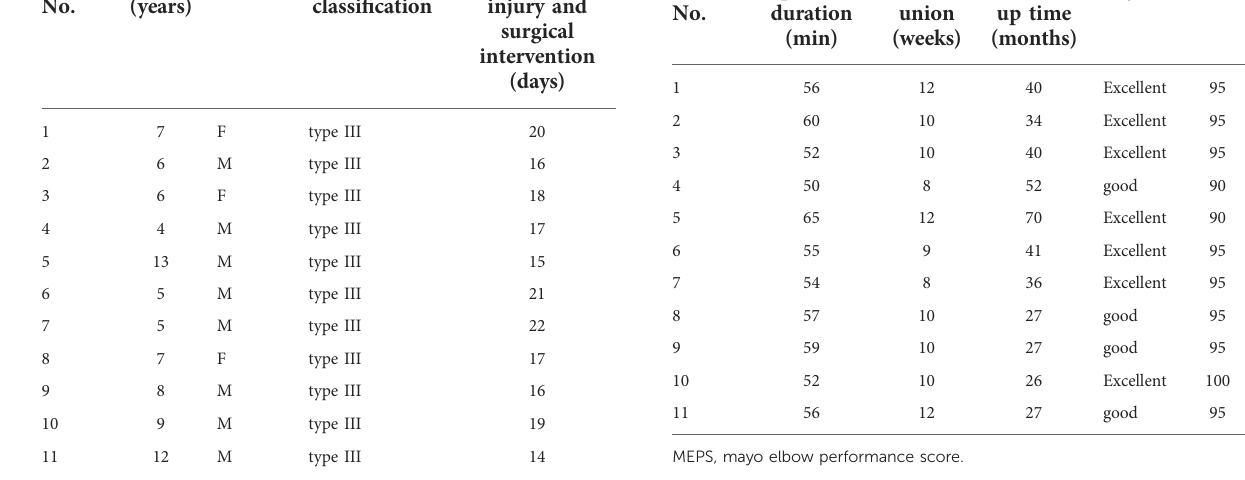
TABLE 1 Demographics of patients. Serial No.